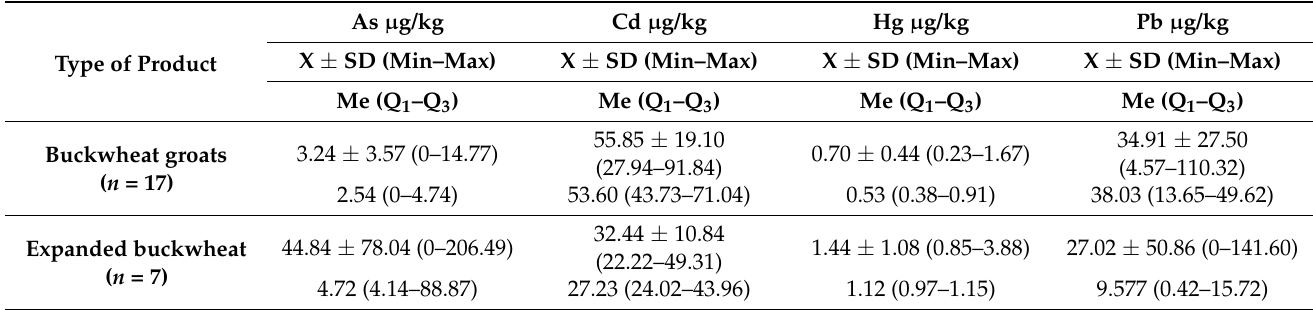
Table 1. The content of the toxic elements in buckwheat